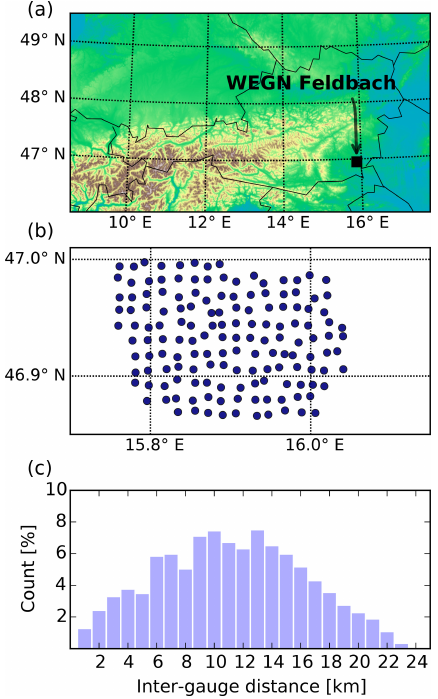
Figure 1. (a) WegenerNet Feldbach region (WEGN) network in southeastern Austria, (b) location of 150 tipping-bucket rain gauges, and (c) inter-gauge distances, rounded to the nearest 1km bins. The map is created using the Matplotlib basemap toolkit (Hunter,